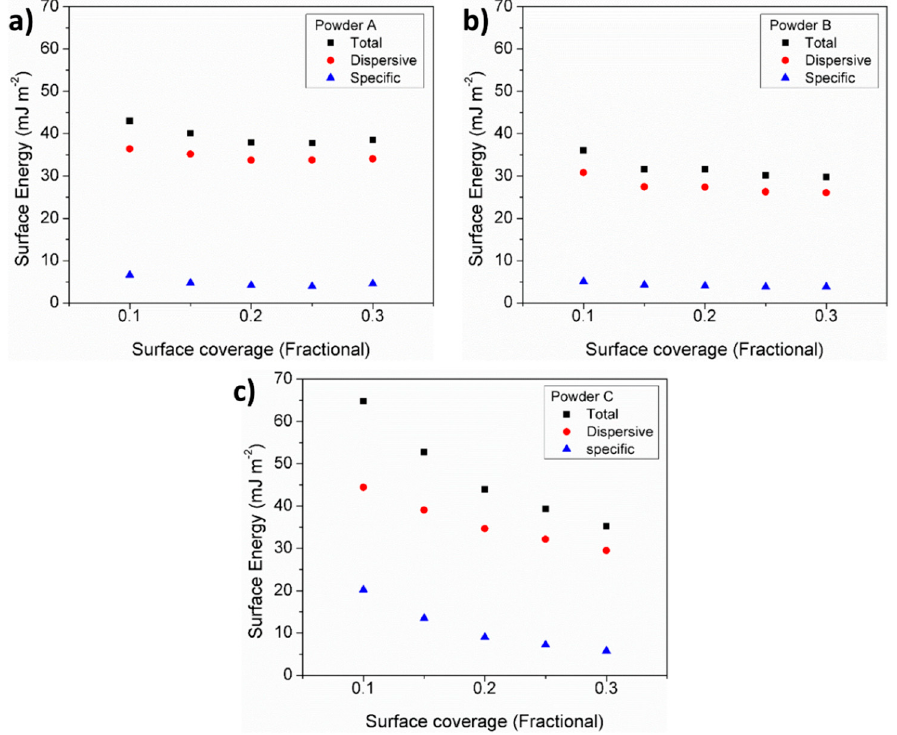
Figure 7. Surface energy of ( a ) powder A, ( b ) powder B, and ( c ) powder C.